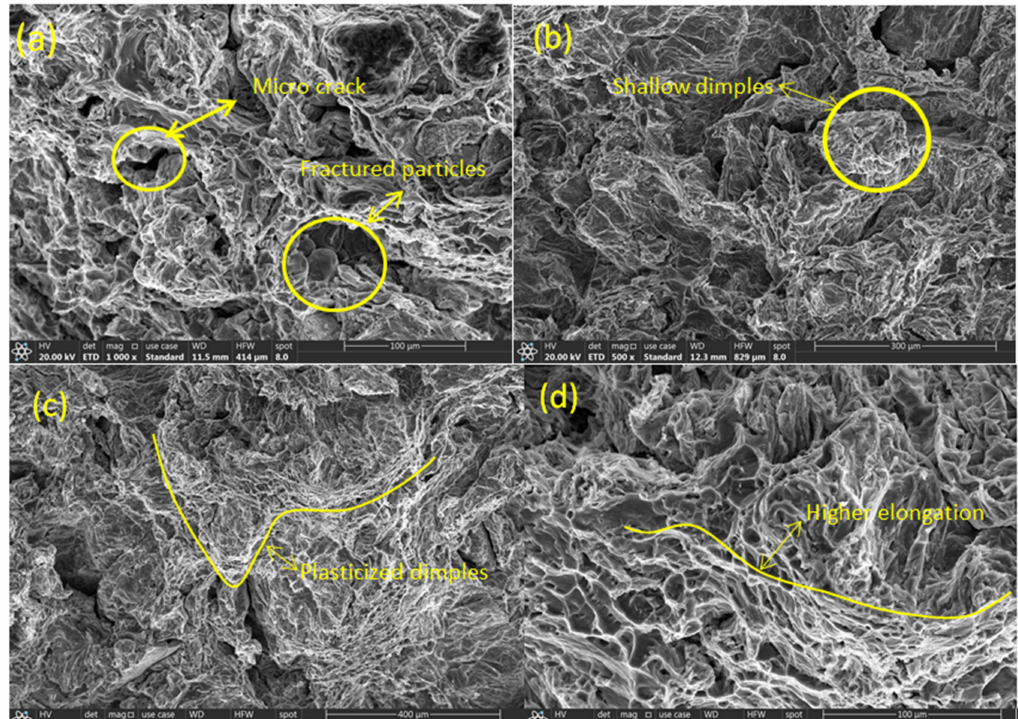
Figure 12. Fracture morphology ( a , b ) at Room temperature failures ( c , d ) at High temperature